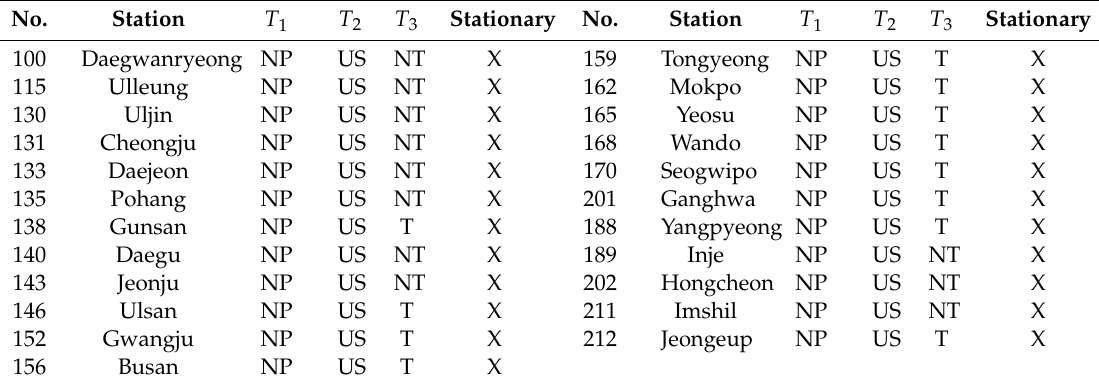
Table 9. Estimation of the stationarity of annual precipitation data using climate change scenarios.